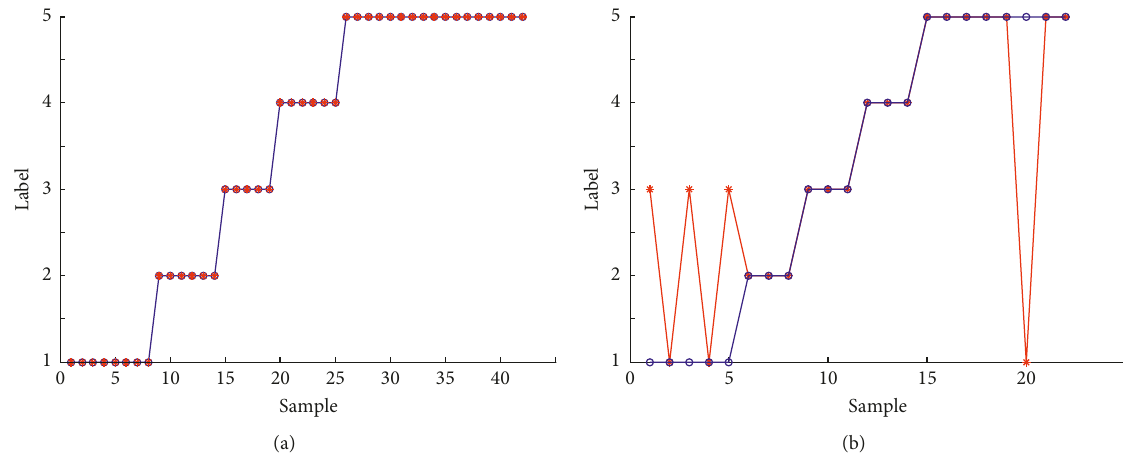
Figure 3: Validation results of the PCA-SVC model for medicinal centipedes: (a) calibration set; (b) prediction set. The red points represent validation results, and the blue points represent reference